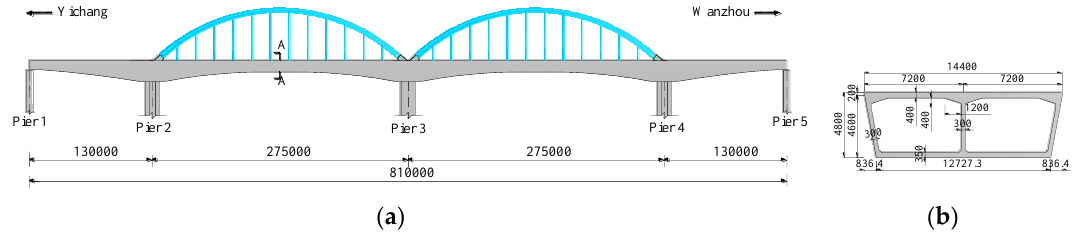
Figure 1. Illustration of the Yichang Yangtze River Bridge (Unit: mm): ( a ) span layout; and ( b ) Section A-A of girder.